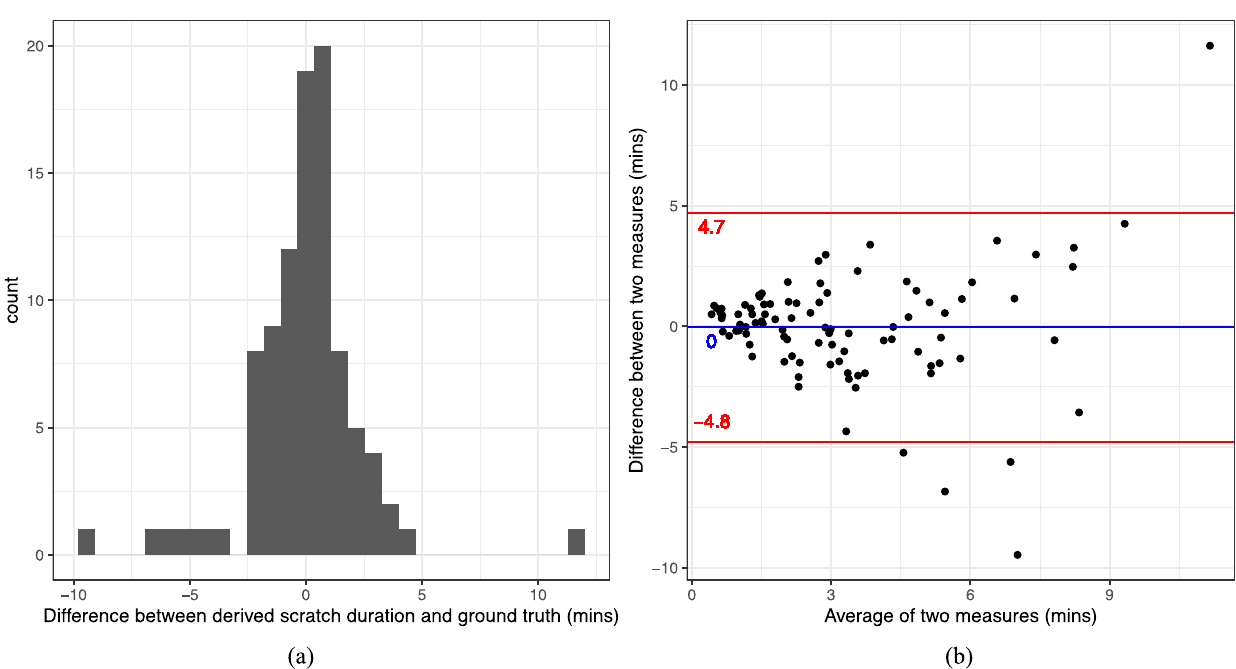
Fig. 3 Assessing consistency between ground truth and model-derived endpoints. a Histogram of difference between derived scratch duration and ground truth. b Bland – Altman